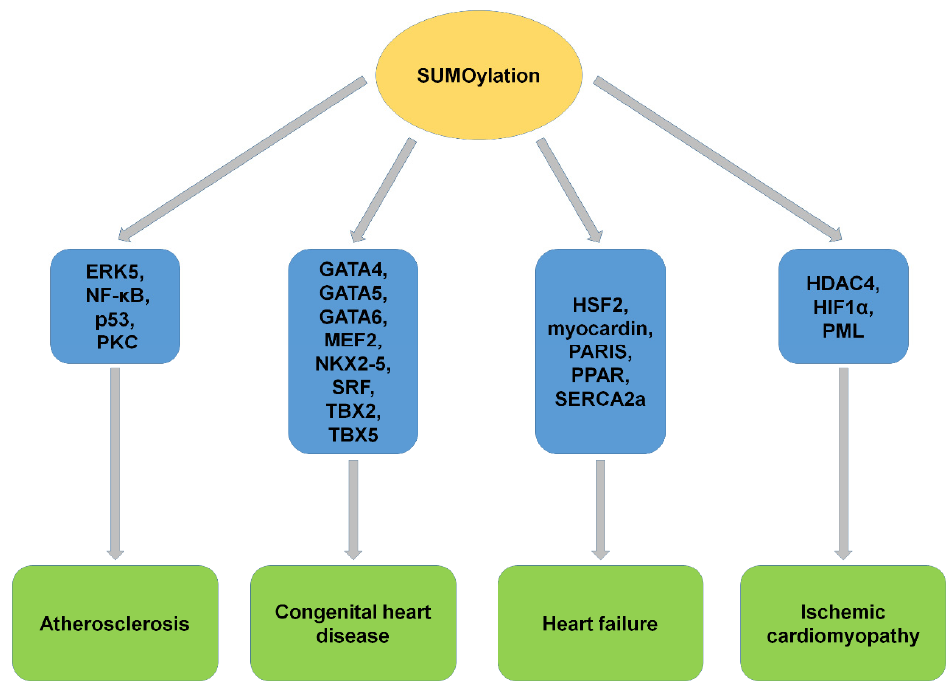
Figure 7. The SUMOylation of substrates and CVD. SUMOylation of target proteins played critical roles and showed potential clinical implications in CVD, including atherosclerosis, congenital heart disease, heart failure, and ischemic cardiomyopathy. ERK5, extracellular signal-regulated kinase 5; PKC, protein kinase C; MEF2, myocyte enhancer factor 2; SRF, serum responsive factor; HSF2, heat shock transcription factor 2; PARIS, parkin-interacting substrate; PPAR γ 1, peroxisome proliferation activated receptor γ 1; SERCA2a, sarcoplasmic/endoplasmic reticulum Ca 2+ -ATPase 2a; HDAC4, histone deacetylase 4; HIF1 α , hypoxia-inducible factor 1 α ; PML, promyelocytic leukemia.